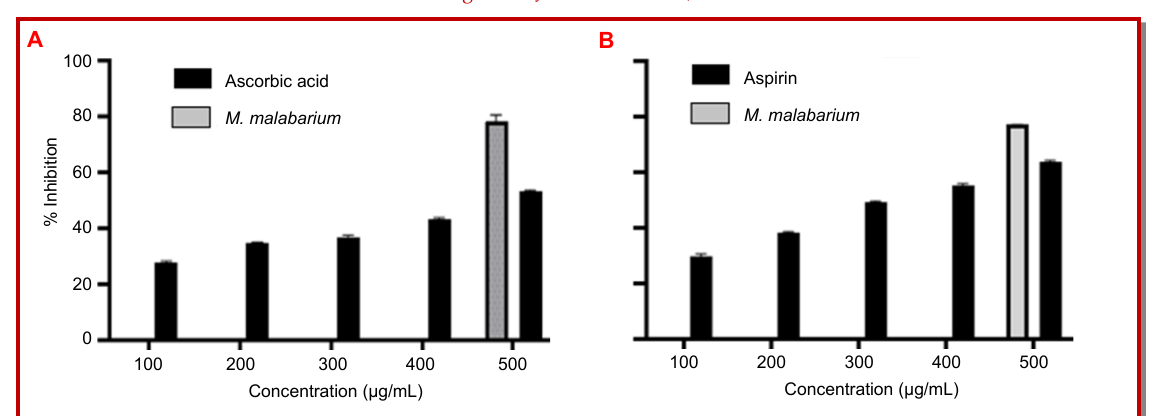
Figure 1: Antioxidant (A) and in vitro anti-inflammatory (B) activities of Memecylon malabaricum leaves